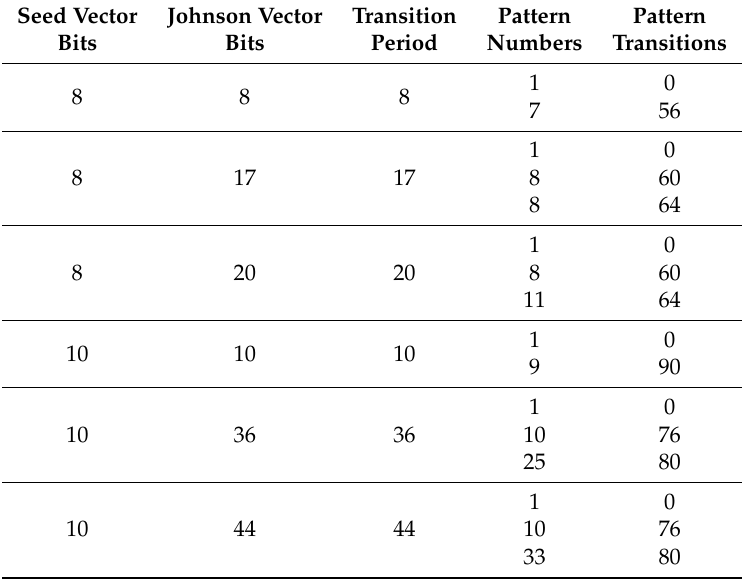
Table 1. Transition of the broadcast-based multiple single input charge (BMSIC)-TPG. Seed Vector Johnson Vector Transition Pattern Pattern Bits Bits Period Numbers